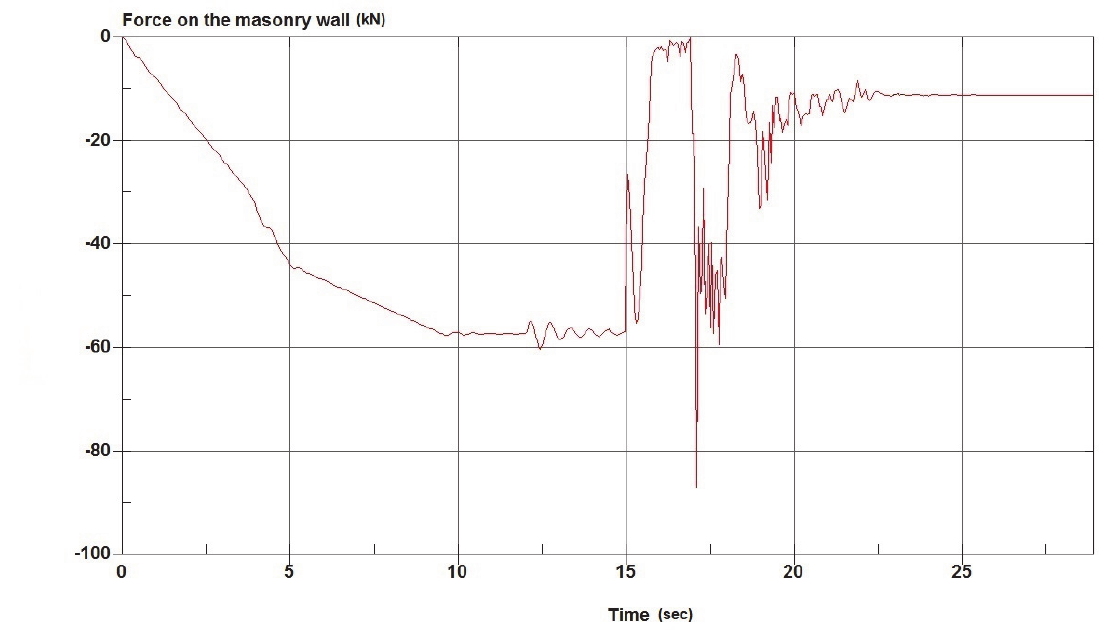
Figure 9: Force time history on the collapsed